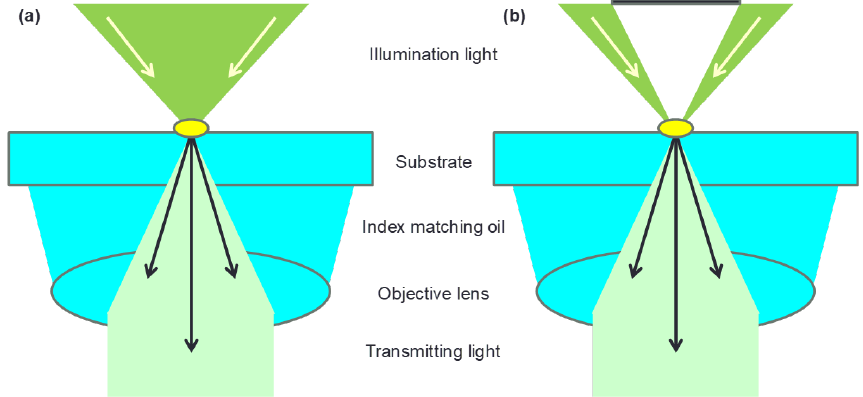
Figure 4. Optical microscopy in a ( a ) bright field and ( b ) dark